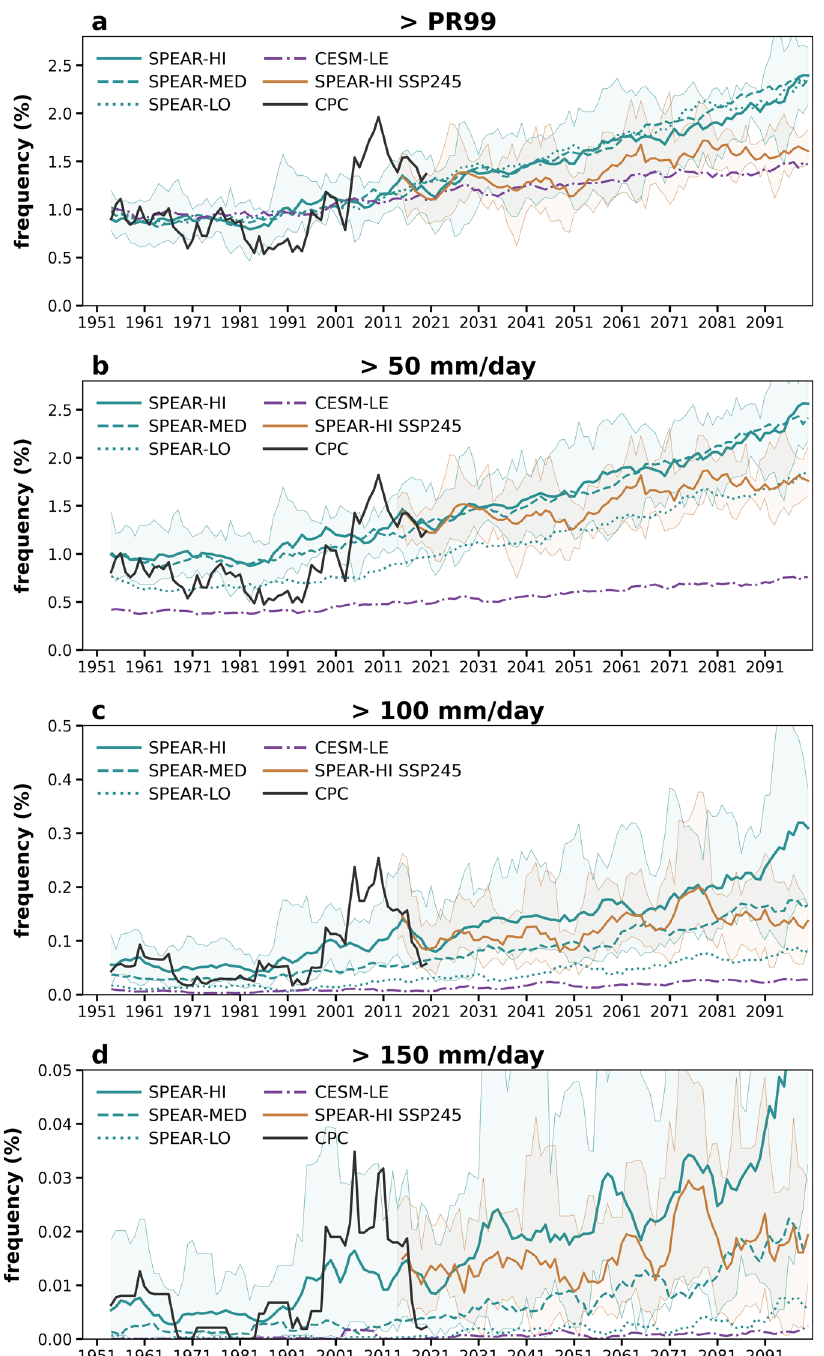
Fig. 2 Time series showing the changes in the frequency of extreme precipitation in each year from 1951 – 2100. a Extreme events are de fi ned as exceeding the 99th percentile threshold based upon 1951 – 2020 from each dataset or model (see “ Methods ” ). b – d As in ( a ), but extreme events are de fi ned as exceeding thresholds of 50 mm/day, 100 mm/day, and 150 mm/day. The observation is shown in black lines. The ensemble mean of SPEAR_LO, SPEAR_MED, and SPEAR_HI historical and SSP5-8.5 simulations are shown in green dotted, dashed, and solid lines, respectively. The SPEAR_HI SSP2-4.5 simulations for 2015 – 2100 are also included (orange solid lines). The ensemble mean of CESM- LE historical and RCP5.8 simulations is presented by purple dash-dotted lines. Only the spreads of SPEAR_HI ensemble members are shown. The ensemble spreads for the other models are included in Supplementary Figs. 5 – 7. The time series are smoothed with a 7-year running mean to remove the interannual variability, emphasizing the long-term trend and